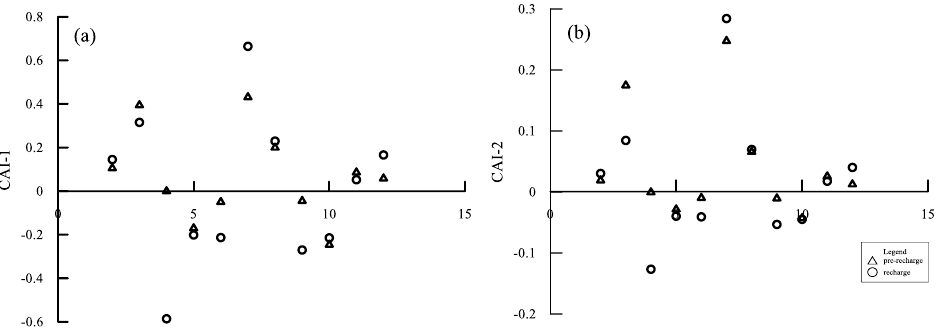
Figure 7. Changes in CAI-1 and CAI-2 of water samples. ( a ) CAI-1 in the two groups of water samples. ( b ) CAI-2 in the two groups of water samples.